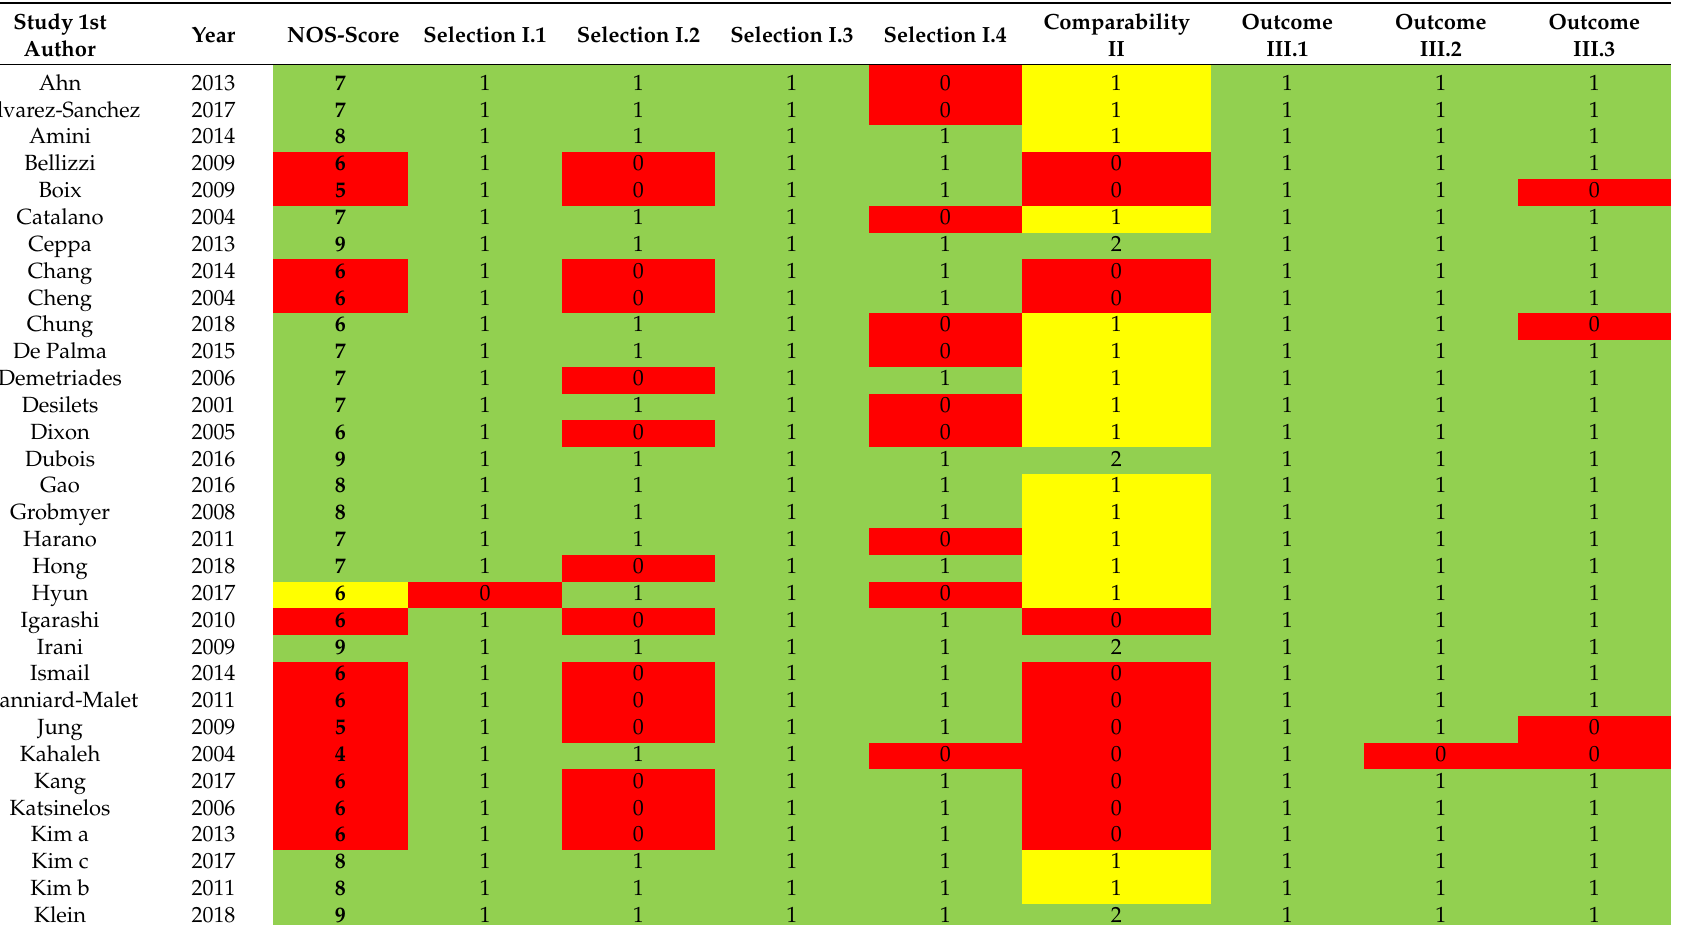
Table 1. Evalulation of the included